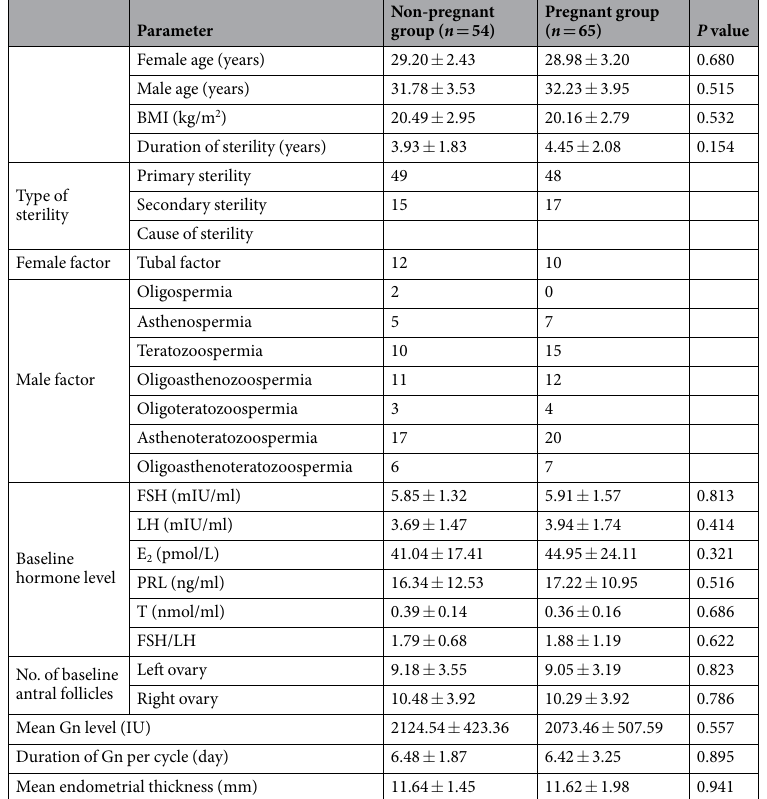
Table 1. Comparison of demographic and clinical characteristics between pregnant and non-pregnant women after